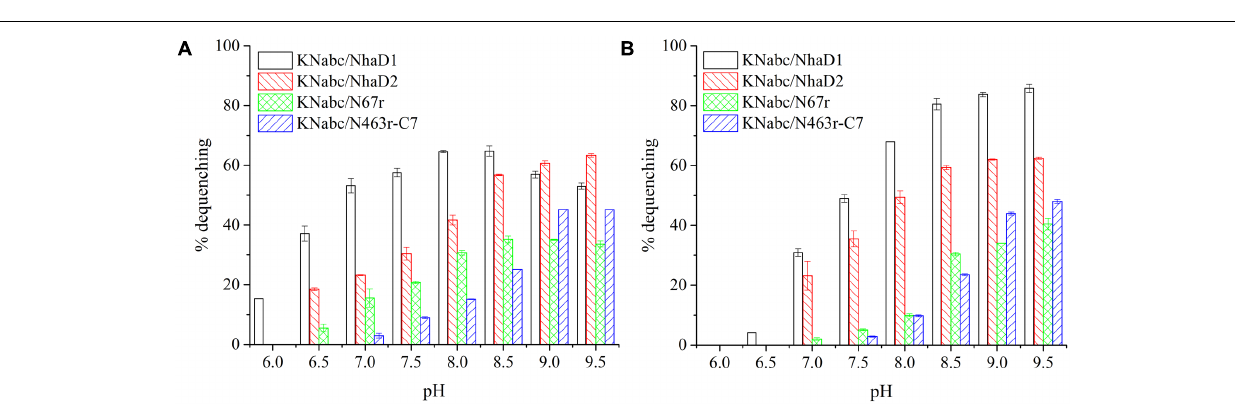
with only two exceptions, i.e., N67 and N463 chimeric proteins ( Figure 2 ). Consistent with the weak growth